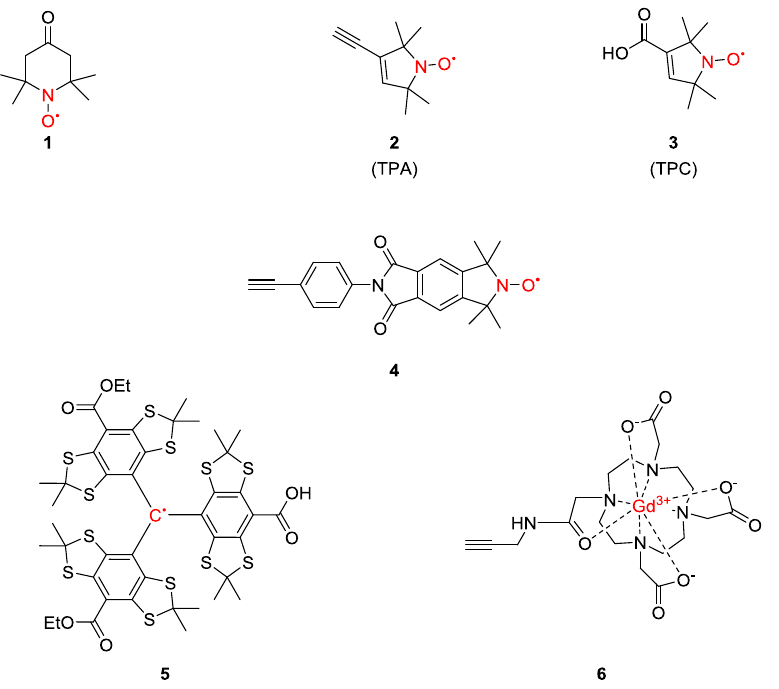
Figure 1. Spin-labels commonly used for model